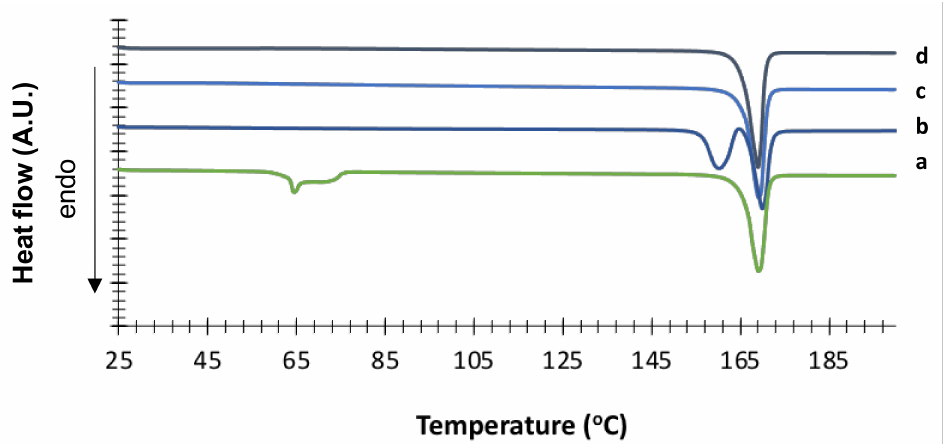
Figure 5. DSC traces of crystallized mannitol forms: (a) hydrate; (b) δ form (1% PVP); (c) β form; (d) α form (2%